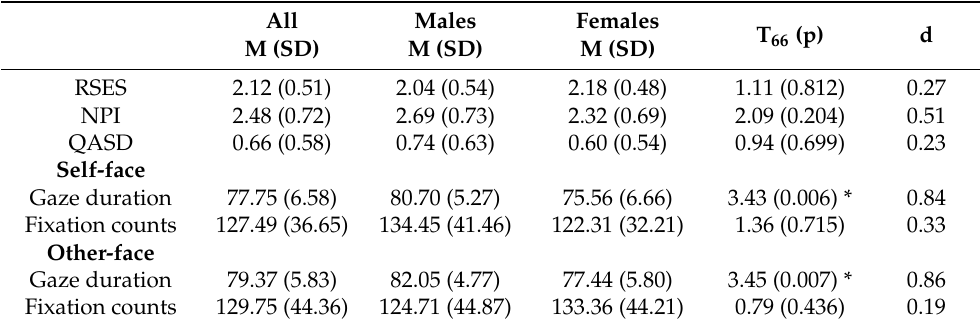
Table 3. Descriptive statistics and gender